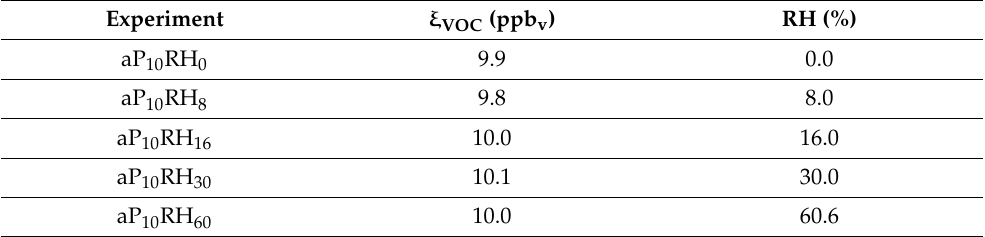
Table 2. Parameters for all rate of NPF UVMEC experiments reported herein. n = 1 for each